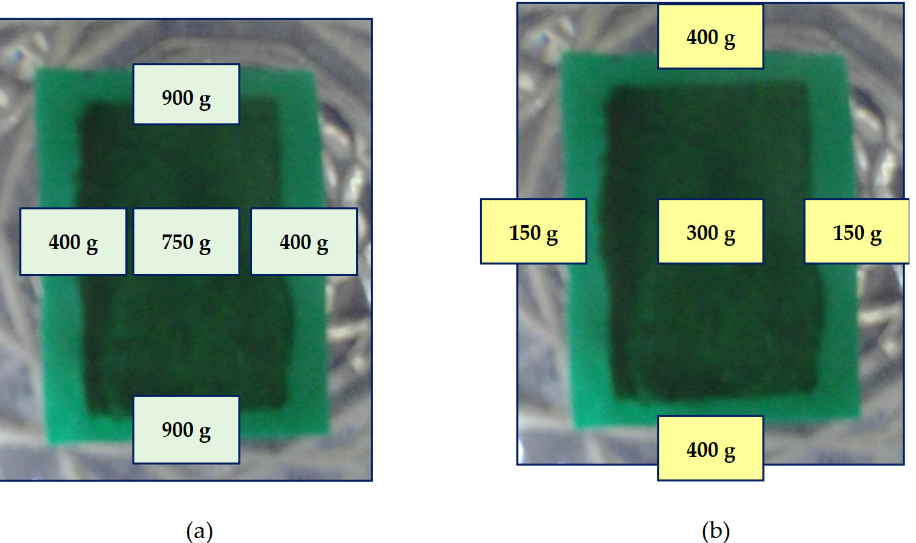
Figure 1. Magnetic field ( a ) On contact with the rubber dam; ( b ) At a distance of 1 mm. The different intensities detected at contact with the dam and at a distance of 1 mm were due to the rapid decays with the distance due to its dipolar nature. Despite its small size (2 × 3 cm) and minimal thickness (approx. 0.5 mm), the dam generated a magnetic field whose lines extend into the surrounding area.